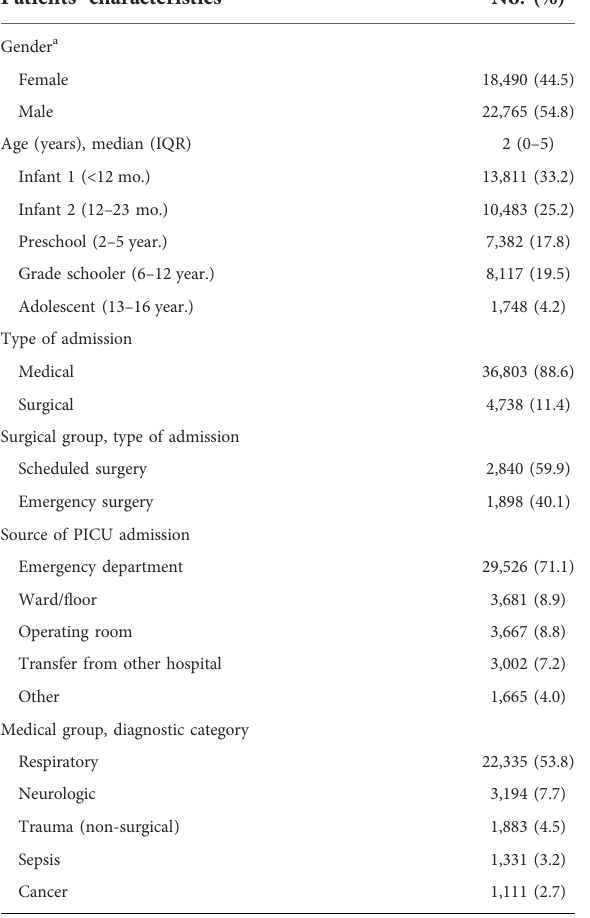
TABLE 2 Characteristics of the study population ( n =41,541). Patients ’